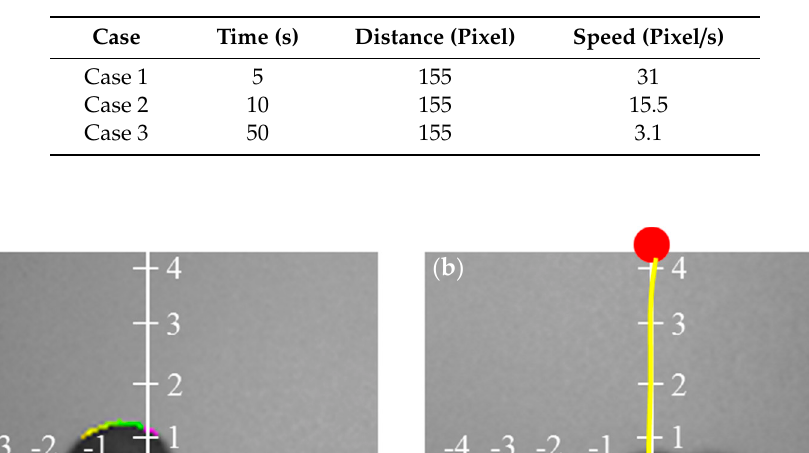
Table 15. Condition setting for rudder plane control.